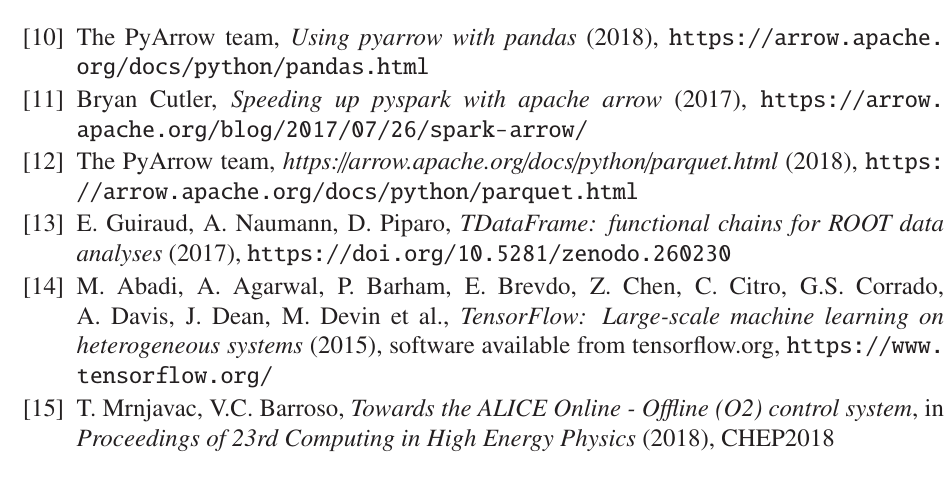
Figure 2. Digitization workflow on-going as shown in the topology viewer of debug GUI, running on